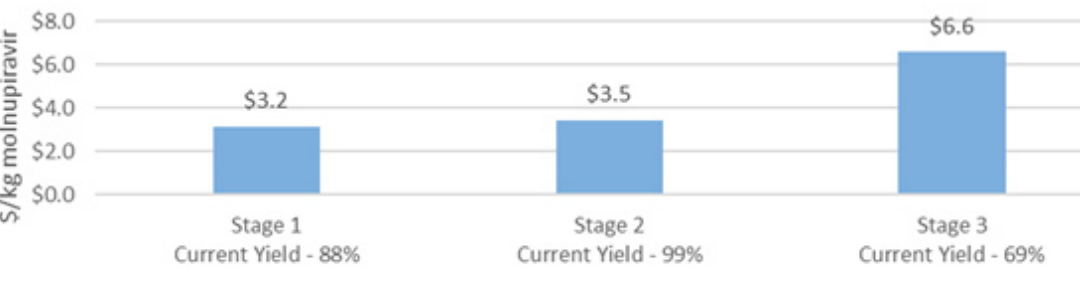
Figure 3. M4ALL Improved Uridine Route maximum COGs decrease per 1% yield improvement in each